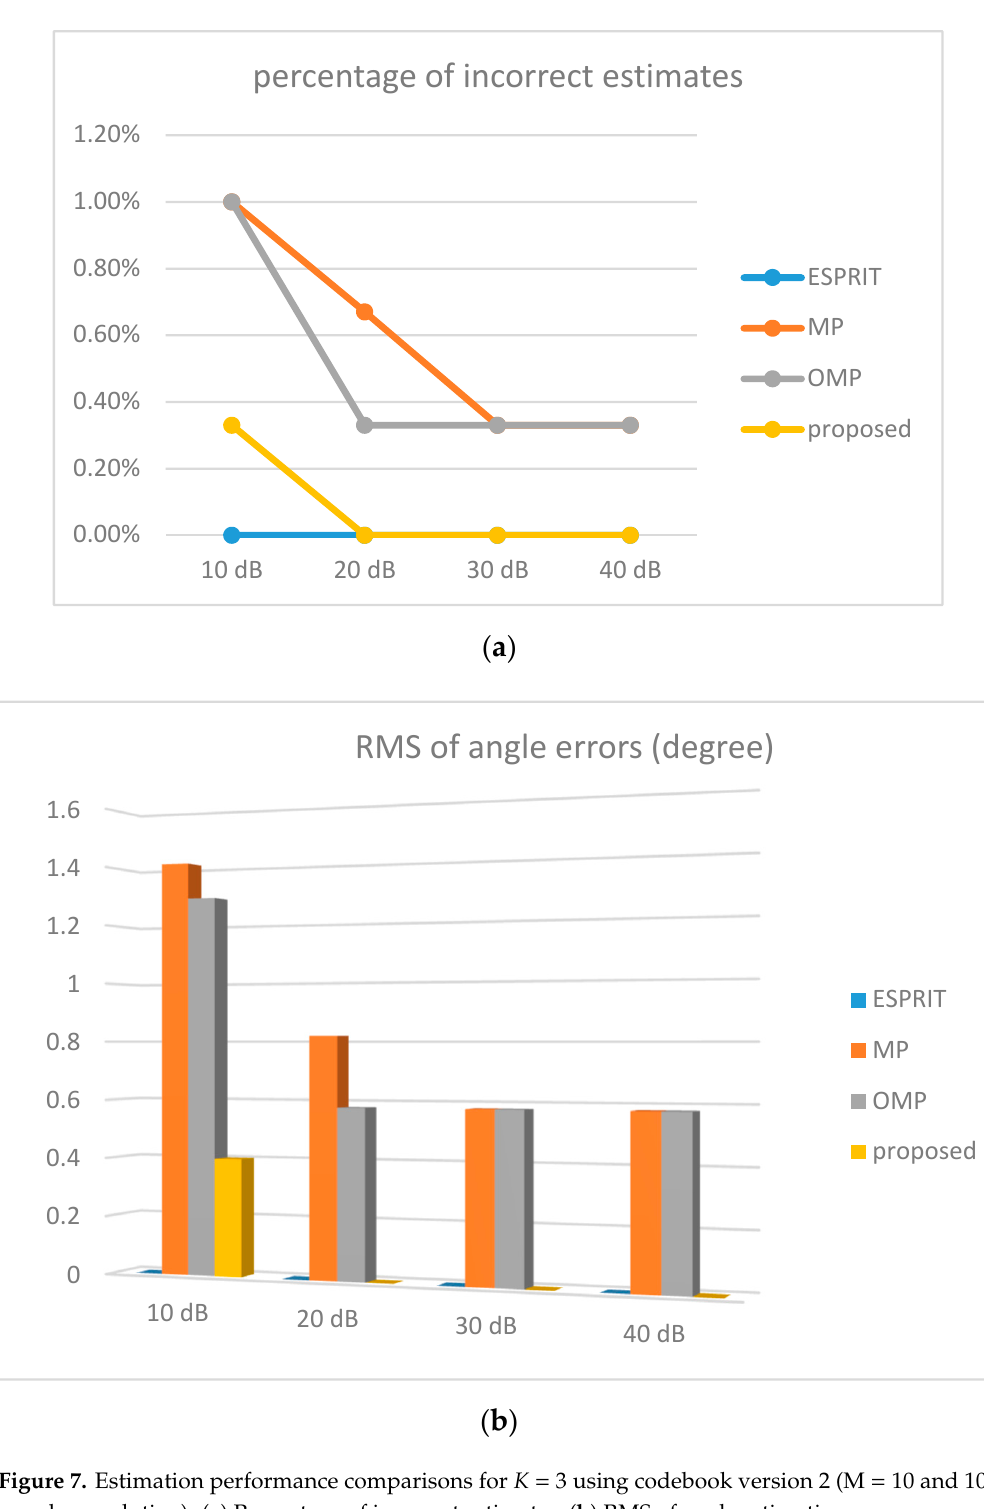
Figure 7. Estimation performance comparisons for K = 3 using codebook version 2 (M = 10 and 10° angular resolution). ( a ) Percentage of incorrect estimates; ( b ) RMS of angle estimation errors.